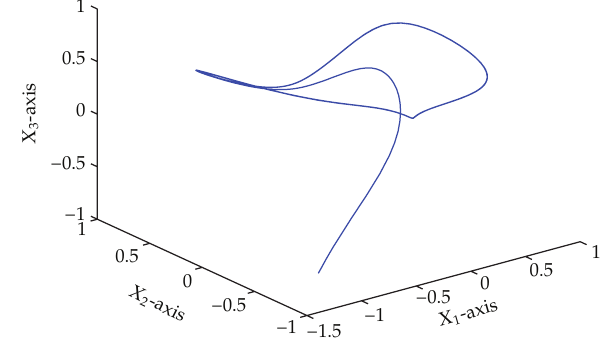
Figure 4: Phase response of state variables x 1 ,x 2 and x 3 in Example